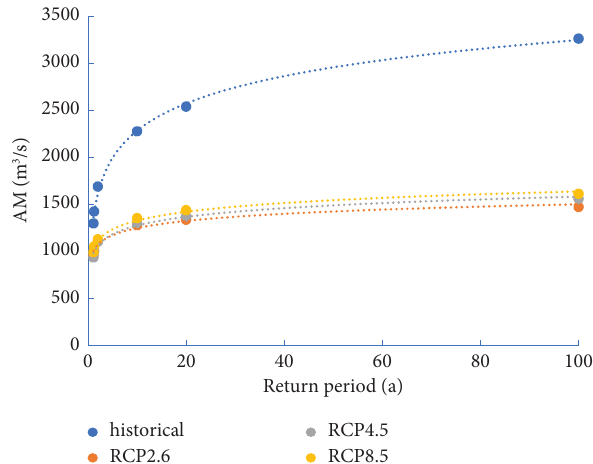
Figure 6: Annual maximum daily runof with diferent return periods.